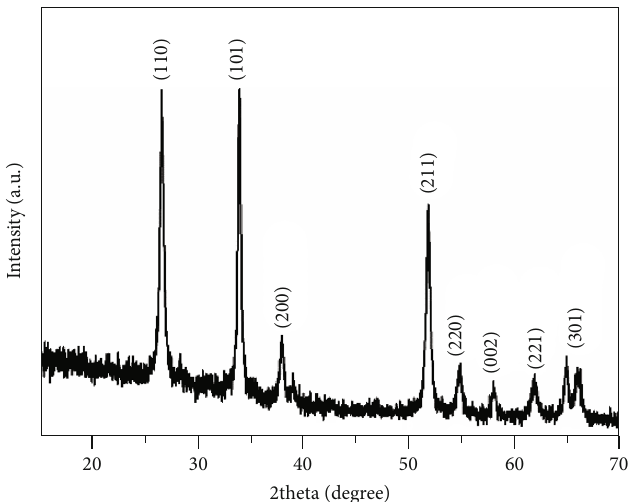
Figure 1: XRD di ff raction pattern of Zn-SnO